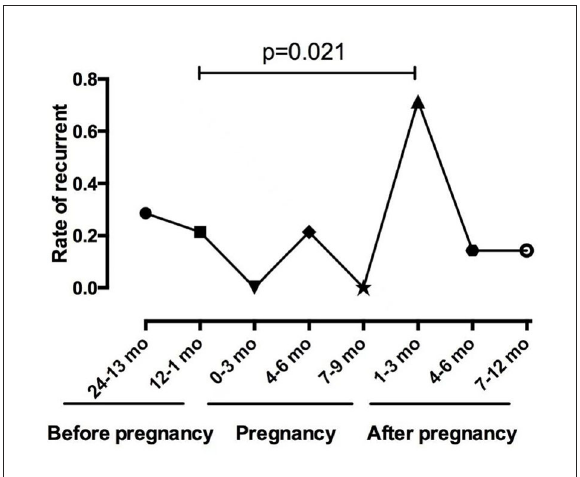
FIGURE3 Comparison of the rate of recurrence in different periods of ON in the 14 patients.